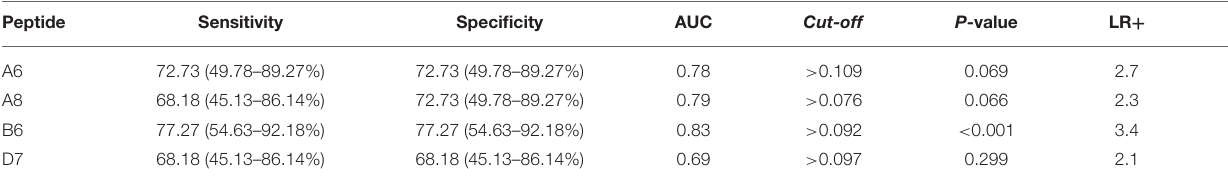
TABLE 2 | Clone reactivity when using individual sera from HTLV-1 carriers. Peptide